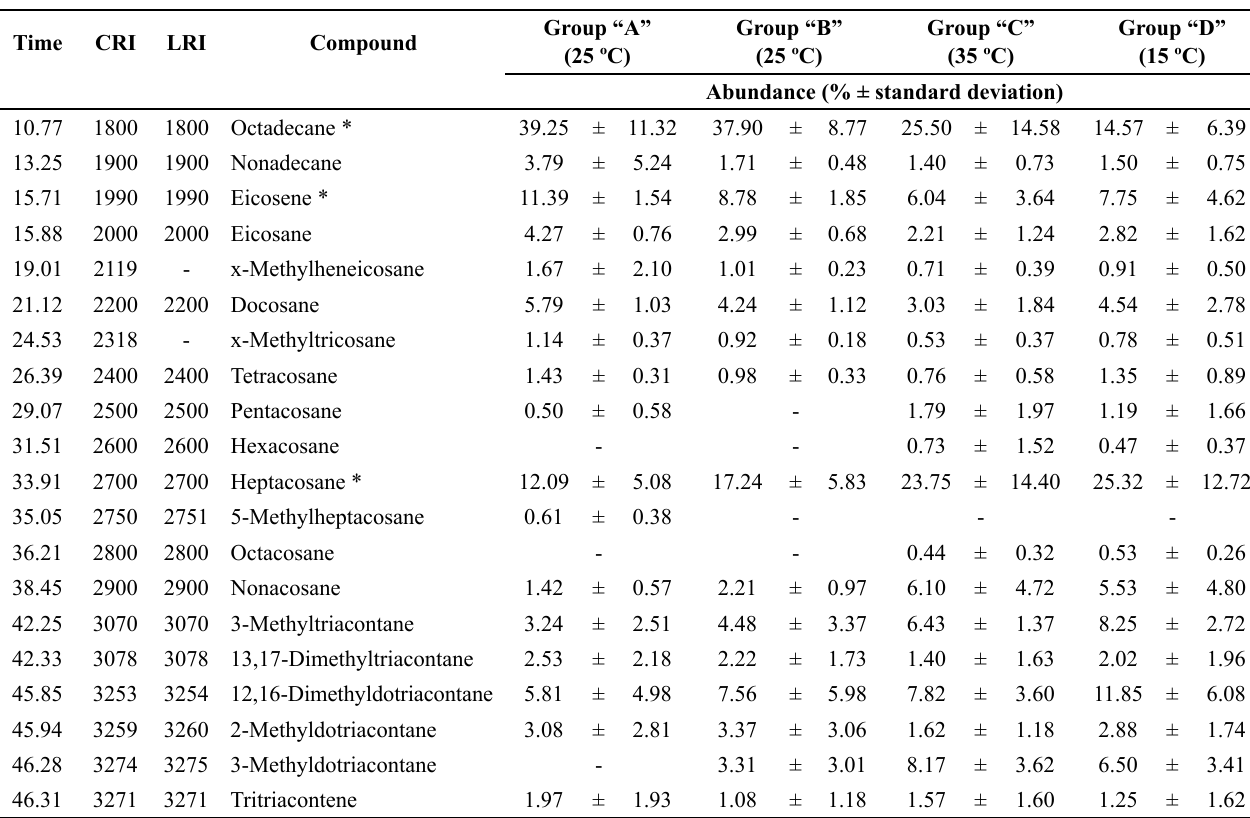
Table 1. Relative abundances (peak areas) of the compounds detected in the cuticles of Odontomachus brunneus workers submitted to different treatments.